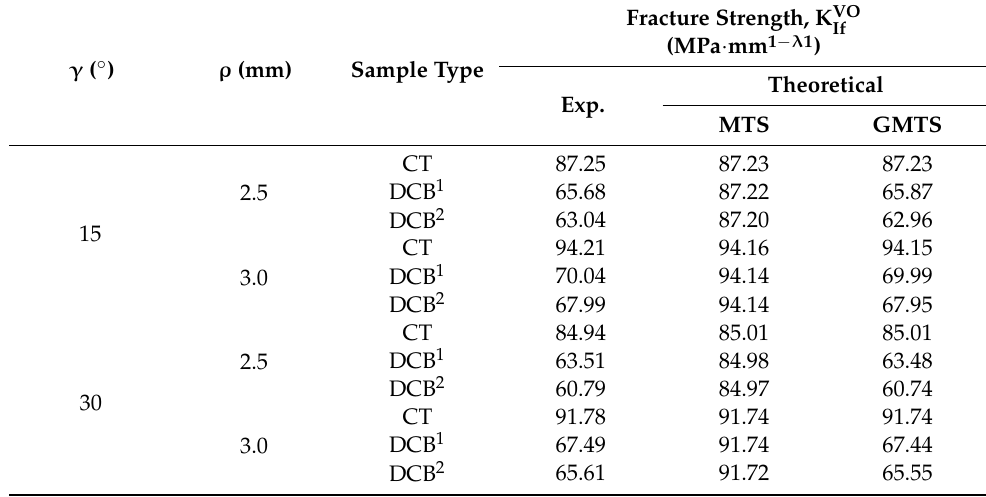
Figure 16. Experimental and theoretical (GMTS) fracture load variation in terms of specimen width (W) for VO-notched CT and DCB specimens. ( a ) γ = 15 ◦ ; ( b ) γ = 30 ◦ . Table 7. Results of the fracture strength predicted through MTS and GMTS